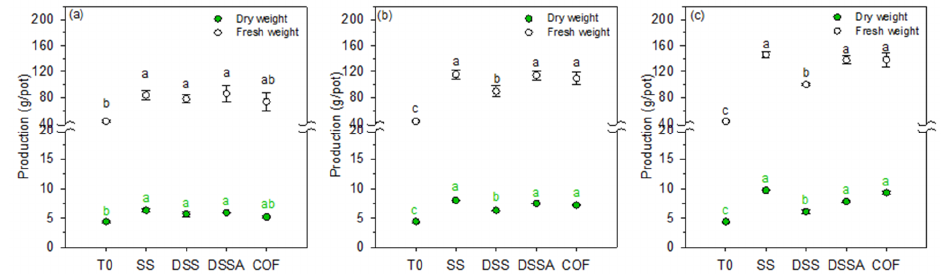
Figure 2. Production (g/pot) as fresh and dry weight of lettuce for the different added soil amend- ments at application rates of ( a ) T1 – 85 kg N/ha; ( b ) T2 – 170 kg N/ha; ( c ) T3 – 255 kg N/ha (T0 -0 kg N/ha; mean values and standard deviations of four replicates of each treatment; the Tukey test was conducted separately for the dry weight (green letters) and fresh weight (black letters), and also for each figure independently; different letters mean statistically different results).